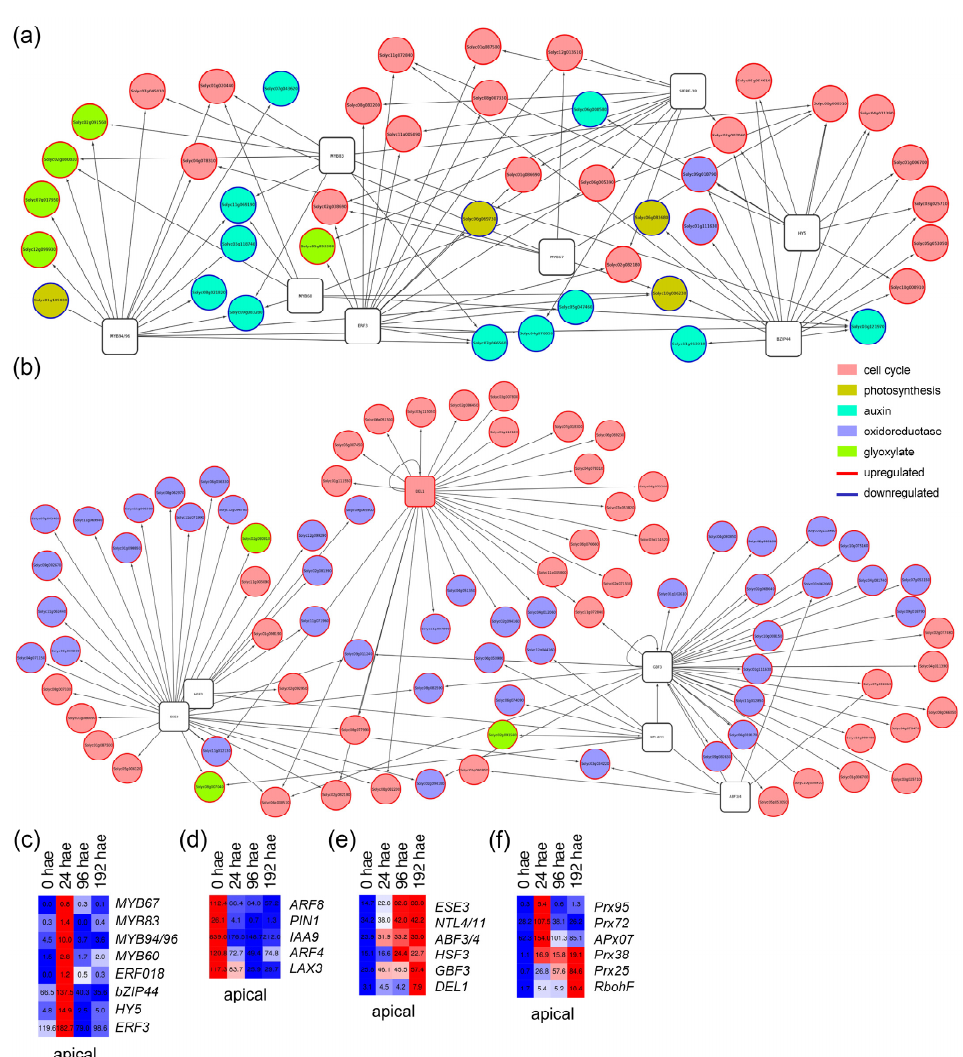
Figure 4. GRNs for putative TF genes and their deregulated targets associated with P11 and P13 profiles in the apical region of the hypocotyl. ( a , b ) Selected GRNs from P11 ( a ) and P13 ( b ) profiles. ( c – f ) Hierarchical clustering over time of selected TF genes ( c , e ) and some of their putative targets ( d , f ) from P11 ( c , d ) and P13 ( e , f ) profiles. Blue/white/red in ( c – f ) indicate normalized cpm values in each row, where red indicates the highest abundance of transcripts. Gene annotations are found in Tables S1 and S4.